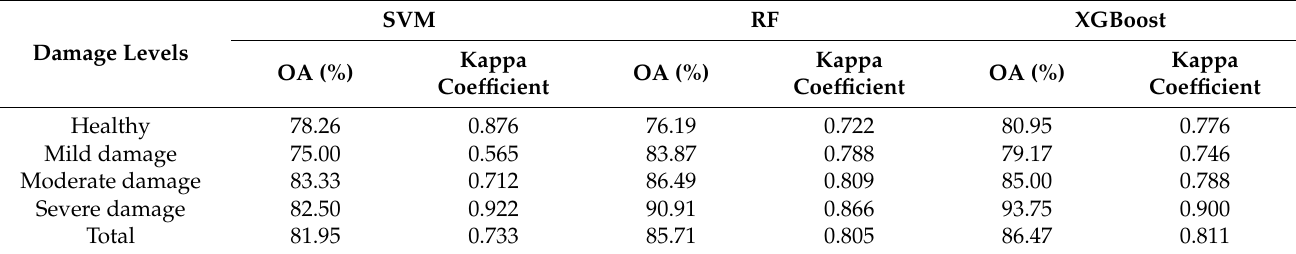
Table 3. Evaluation of the detection performance for SVM, RF, and XGBoost